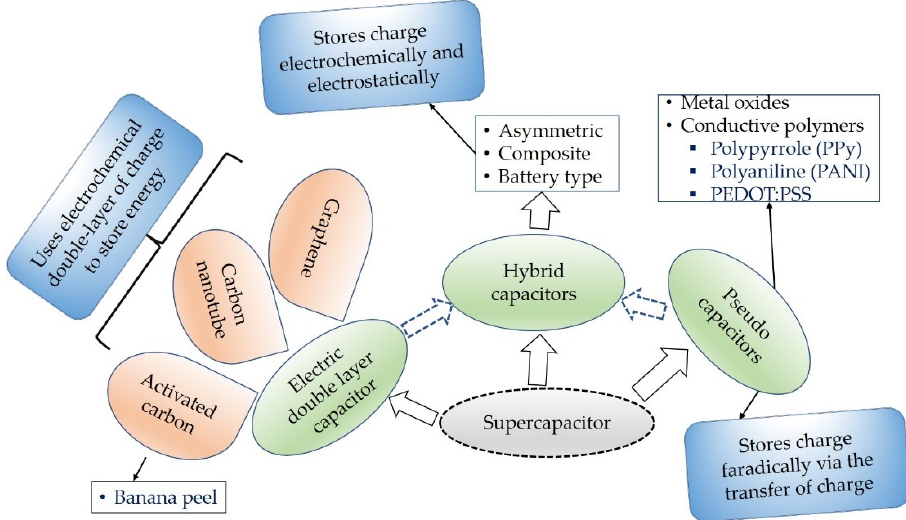
Figure 1. Types of supercapacitors based on its working